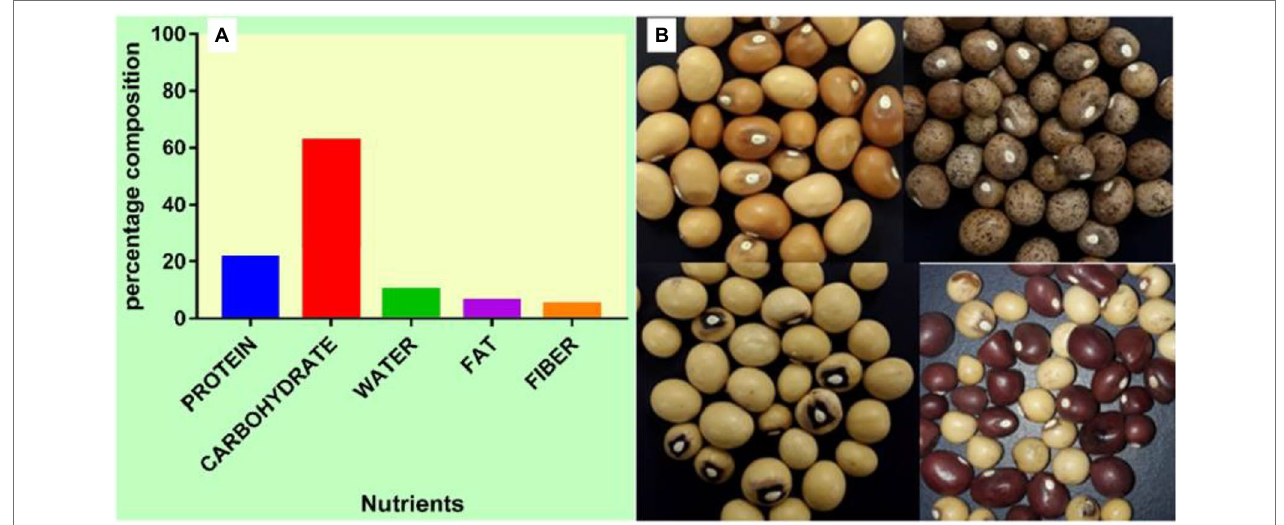
FIGURE 1 | (A) Percentage nutrient composition of BGN. (B) Seeds of BGN showing variations in color, shape, and eye